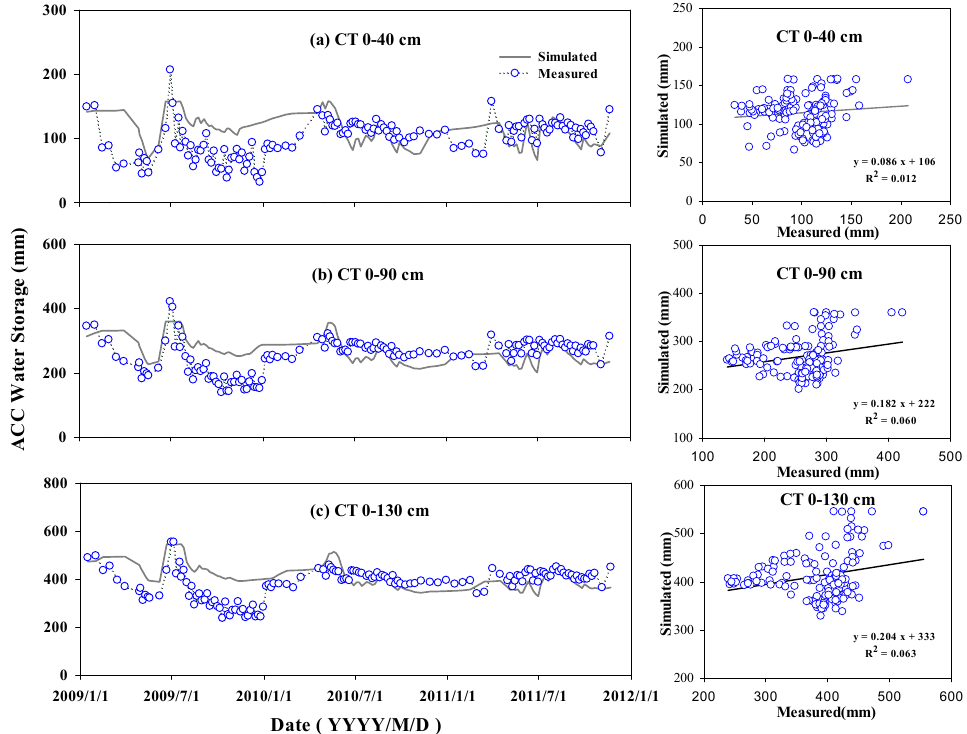
Figure 4. Simulations vs. measurements of water storage at ( a ) 0–40 cm, ( b ) 0–90 cm, and ( c ) 0–130 cm for CT during 2009–2011.